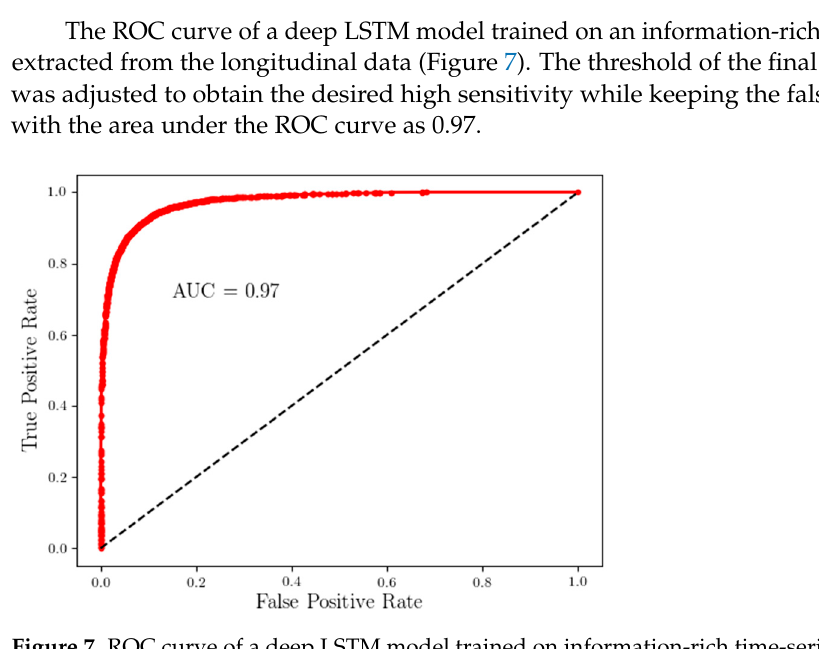
Figure 7. ROC curve of a deep LSTM model trained on information-rich time-series extracted from longitudinal multi-day data.